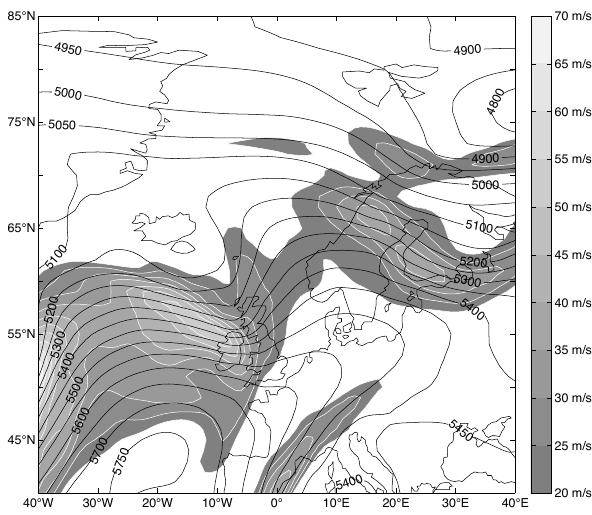
Fig. 2b. Synoptic chart for 06:00UT on 25 January 2003: Geopo- tential height at 500hPa (contours) and wind speed